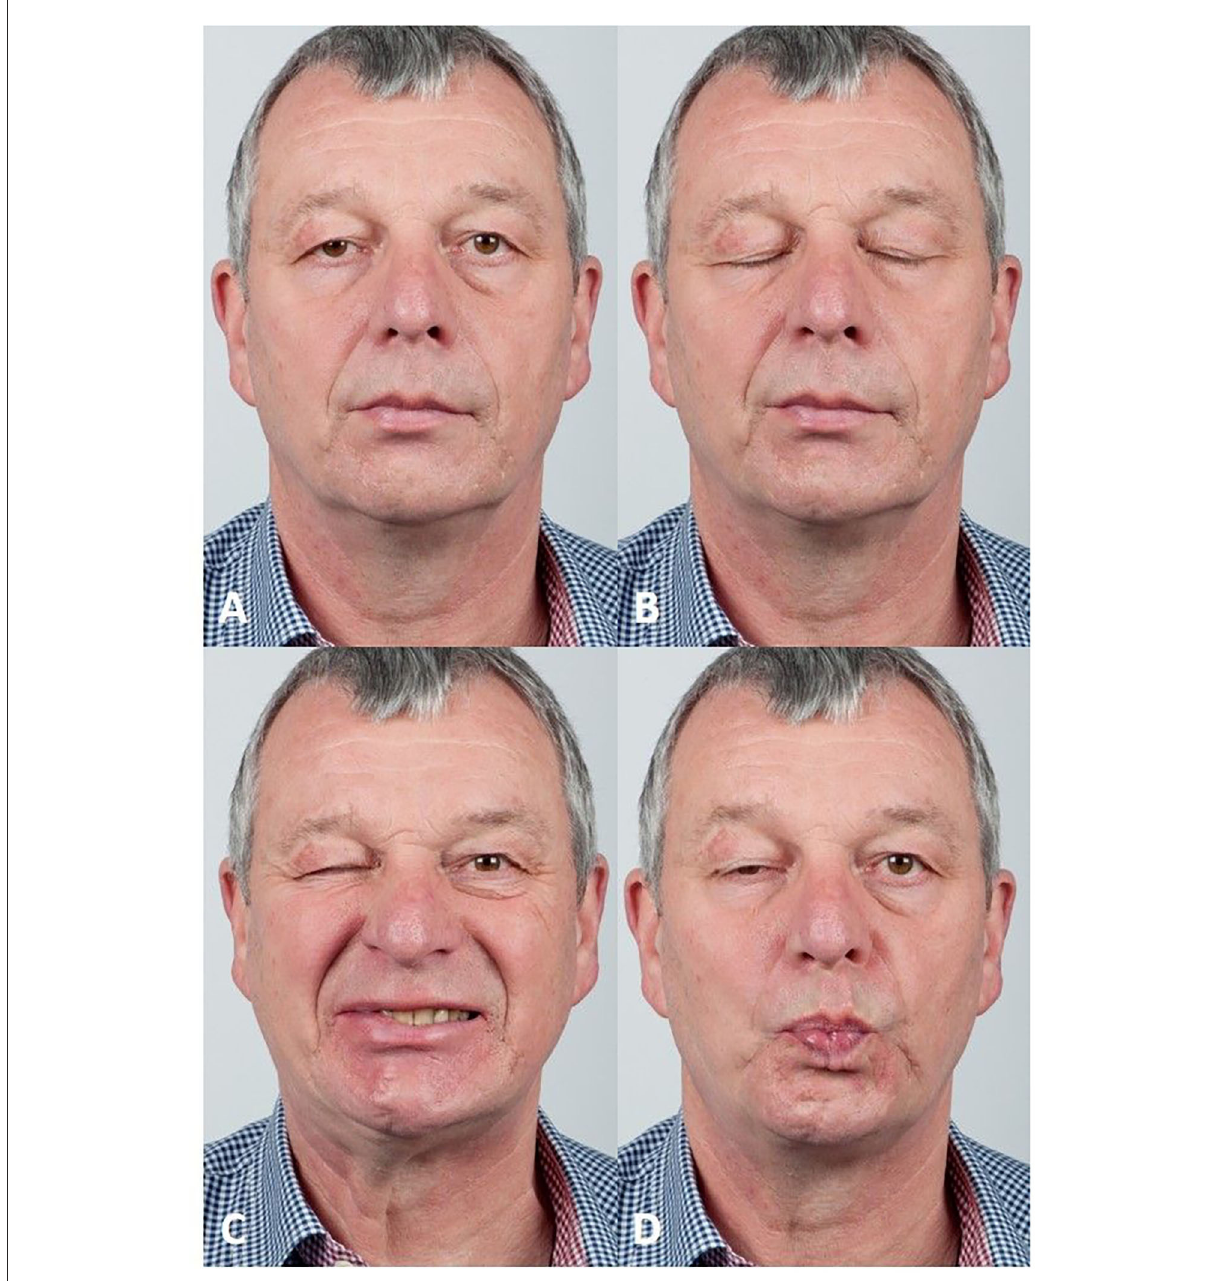
FIGURE2 Example of typical signs of synkinesis at rest and during movements. (A) At rest, a pronunciation of the nasolabial fold on the post-paretic right side and slight ptosis of the upper eyelid is visible. (B) With the exception of a synkinetic activity in the region of the right corner of the mouth, especially in the zygomatic region, eye closure is not accompanied by strong synkinetic muscle activity. Furthermore, disturbing synkinesis of the right depressor anguli oris of the platysma can be observed. (C) The severe oculo-oral synkinesis becomes obvious during smiling leading to a nearly complete involuntary closure of the right eye. (D) The same can be seen when the patient is pursing the lips.